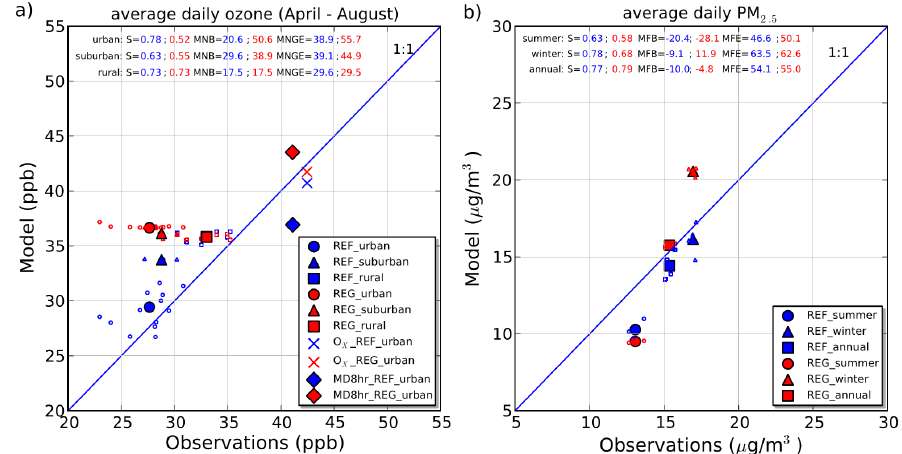
Figure 13. (a) Scatter plots of daily average ozone concentrations at urban, suburban and rural stations from the REF and REG simulations. The odd oxygen (O x ) and daily maximum at urban locations is also shown. (b) Daily average PM 2 . 5 concentrations in wintertime (DJF), summertime (JJA) and on annual basis over urban